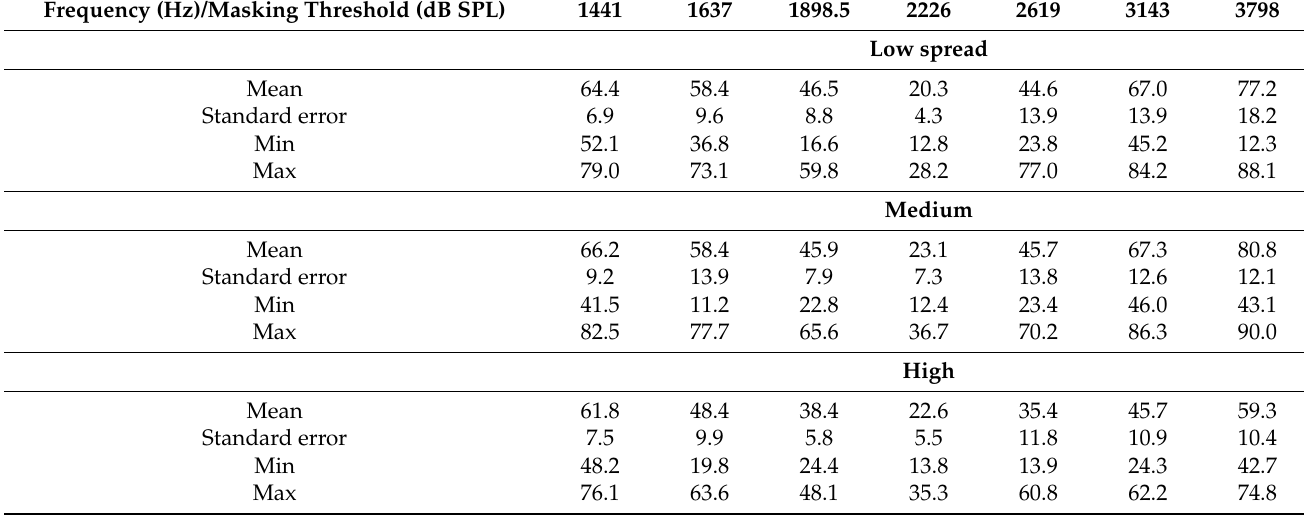
Table 5. Average masking thresholds (in dB SPL) function of the simulated spread of excitation. Frequency (Hz)/Masking Threshold (dB